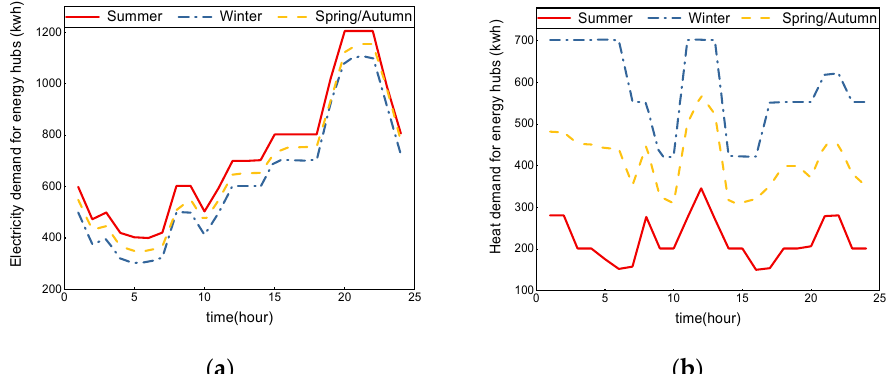
Figure 8. The multi-energy hub system electrical and heat demands in different seasons at 24 h a day: ( a ) electrical demand; ( b ) heat demand.